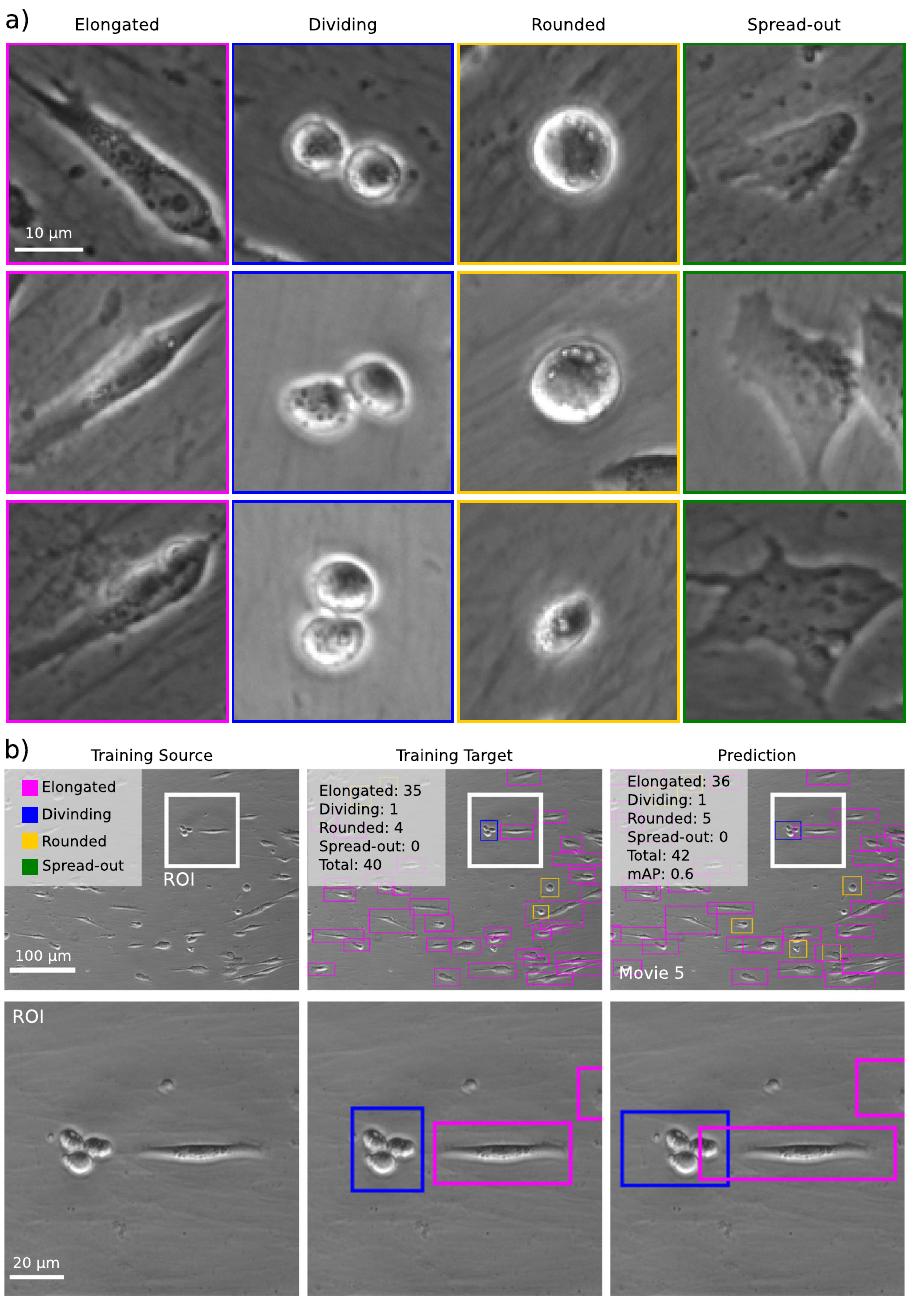
Fig. 3 Object detection (YOLOv2). Example of data generated using the ZeroCostDL4Mic YOLOv2 notebook, detecting and identifying cell shape classi fi cation from a cell migration bright- fi eld time-lapse dataset. a Identi fi ed cell shapes and representative examples that were hand-labelled in the training dataset. b Input, ground truth and prediction obtained from object detection, highlighting the identi fi cation of the presence of three classes in the fi eld-of-view (see also Supplementary Movie 5) and an mAP of 0.60 for this fi eld of view. mAP: mean average precision (see Supplementary Note 2 for details). mAP mean average